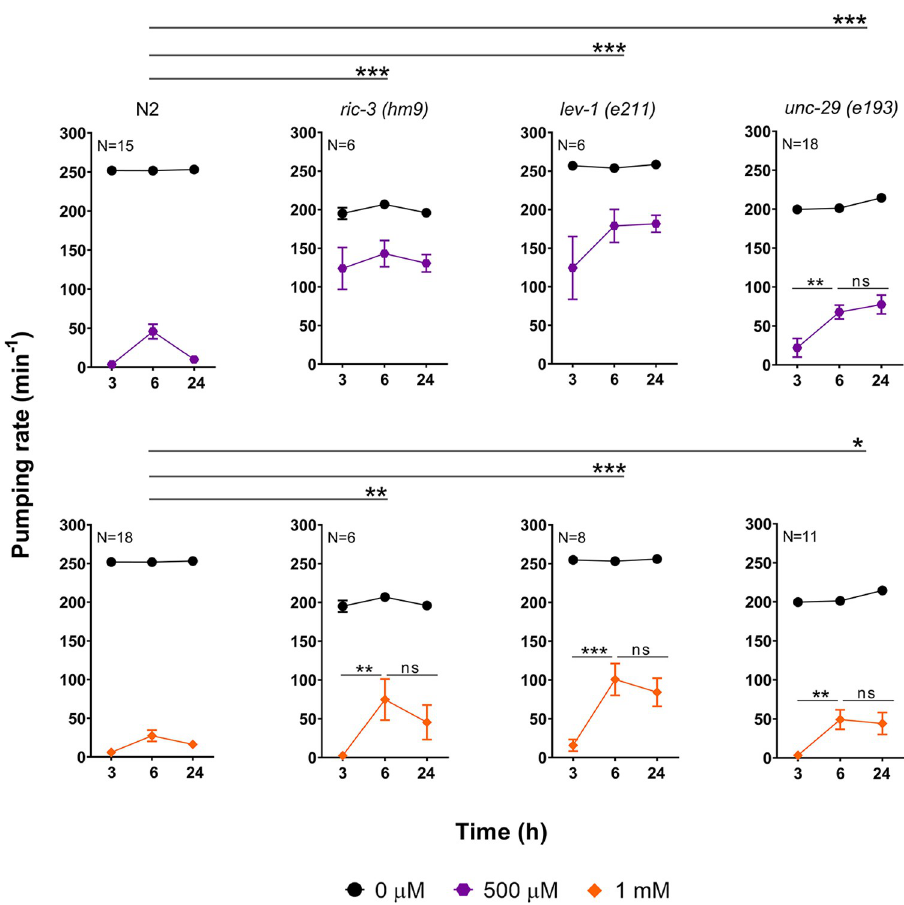
Fig 6. Nematodes deficient in the non-alpha subunits of the L-type body wall muscle receptor, LEV-1 and UNC- 29, exhibited a sustained in drug recovery of the pharyngeal pumping. Paraoxon-ethyl induced plasticity of the pharyngeal function in wild type nematodes exposed to 500 μ M and 1 mM. Data are shown as mean ± SEM of 15 worms in 8 independent experiments (N = 15) or 18 worms in 9 independent experiments (N = 18), respectively. Nematodes deficient in the chaperone protein RIC-3 exhibited resistance to the inhibition of the pumping in the presence of 500 μ M of paraoxon-ethyl. The exposure to 1 mM concentration inhibited the pumping rate after 3 hours and showed an in drug spontaneous recovery sustained for up to 24 hours. Data are shown as mean ± SEM of 6 worms in 3 independent experiments for each concentration (N = 6). lev-1 encodes a non-alpha subunit of the L-type receptor. LEV-1 lacking nematodes phenocopy the paraoxon-ethyl induced sustained in drug recovery of ric-3 deficient nematodes. Data are shown as mean ± SEM of 6 worms in 3 independent experiments (N = 6) for 500 μ M exposure or 8 worms in 4 independent experiments for 1 mM exposure. UNC-29 is the other non-alpha subunit of the L-type receptor. Nematodes deficient in UNC-29 exhibited wild type resistance to paraoxon-ethyl but a sustained in drug recovery of the pharyngeal pharyngeal pumping after 24 hours in 500 μ M and 1 mM. Data are shown as mean ± SEM of 18 worms in 9 independent experiments (N = 18) or 11 worms in 6 independent experiments (N = 11), respectively. Statistical significance was calculated by two-way ANOVA test followed by Bonferroni corrections. ns p > 0.05; * p � 0.05; ** p � 0.01; *** p � 0.001.